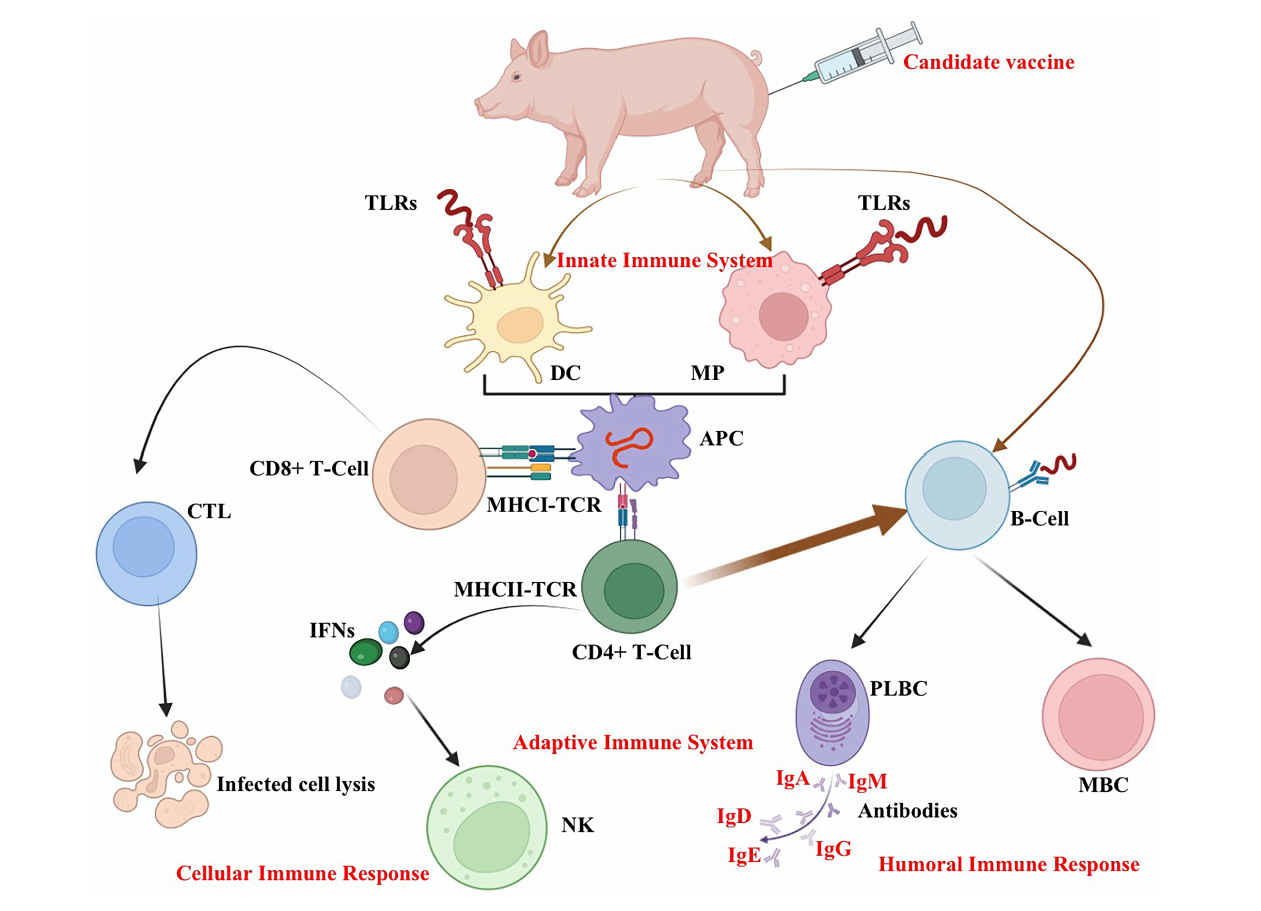
FIGURE1 Descriptive workflow for the epitope-based candidate vaccine